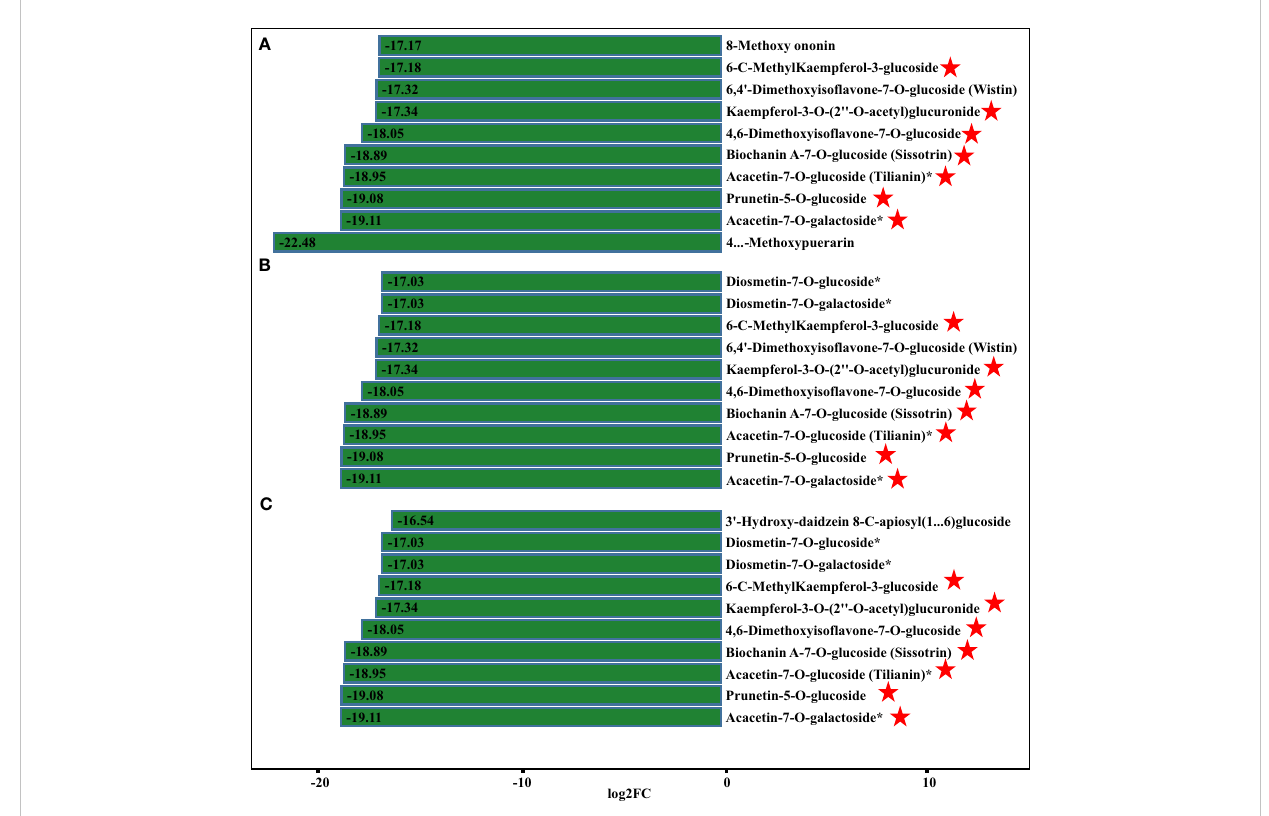
FIGURE 7 Fold-changes of differentially accumulating metabolites. (A) YS vs. HS; (B) YS vs. FG; (C) YS vs. GL. The pentagram represents the common metabolites of the three